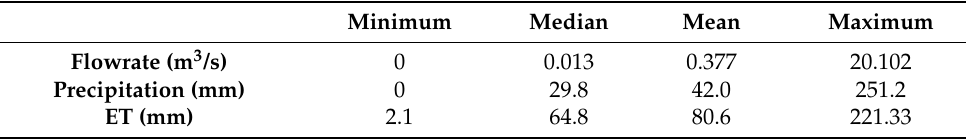
Table 1. Summary of the hydro-meteorological data used for this study.